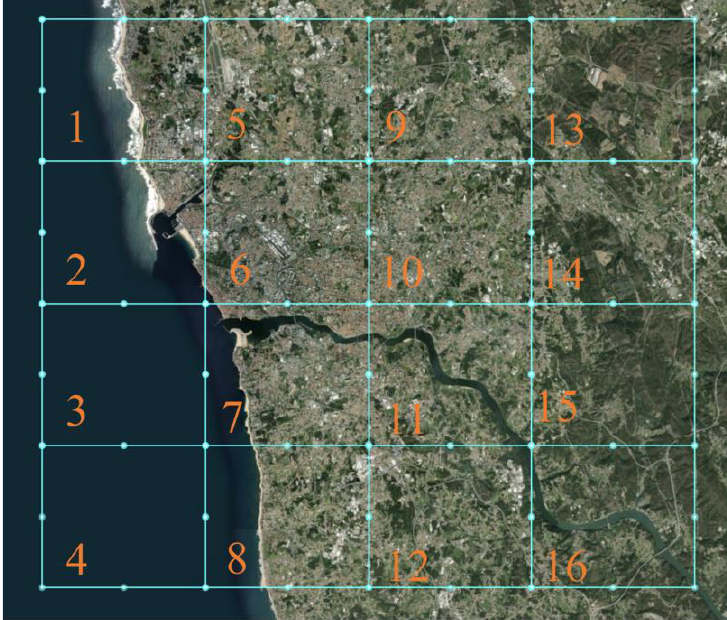
Figure 7. Example of a trajectory taken from the dataset.